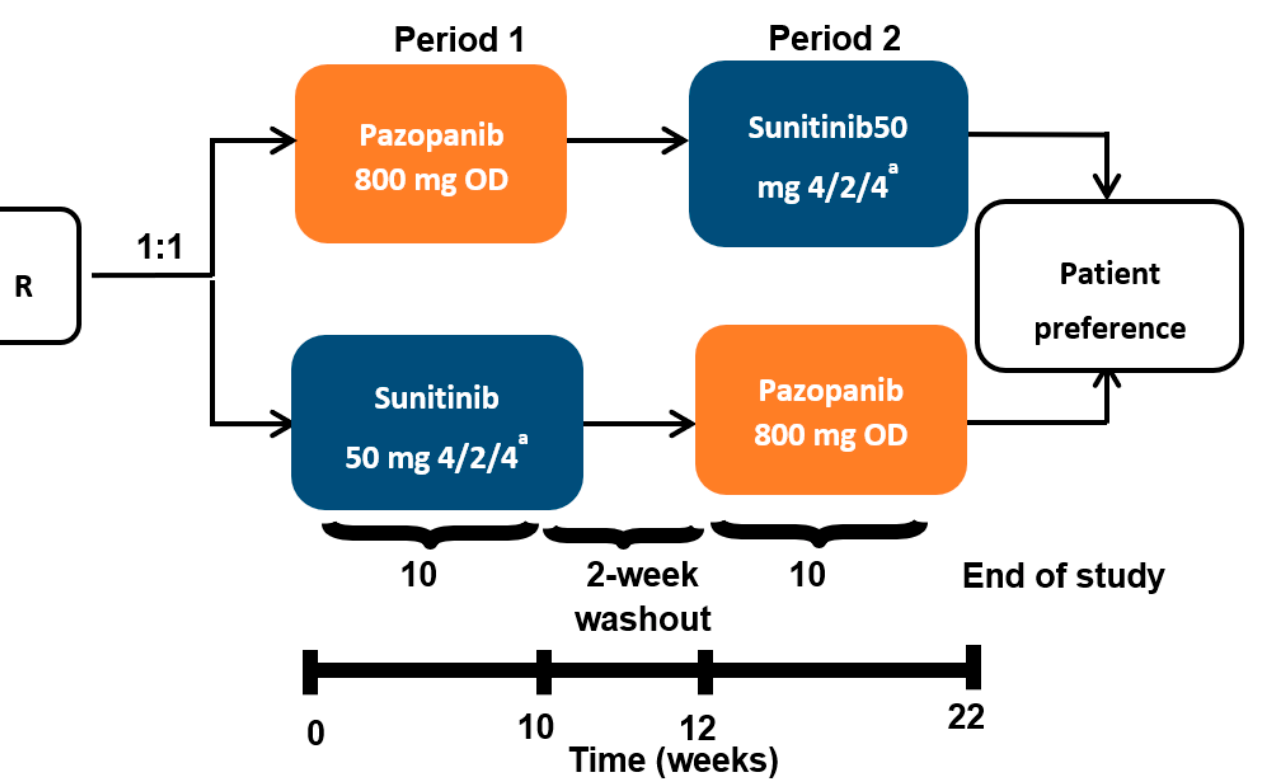
Figure 1. PISCES protocol and blood collection. m RCC patients were randomly assigned to pazopanib 800 mg per day for 10 weeks, followed by a 2-week washout, then sunitinib 50 mg per day (4 weeks on, 2 weeks off, 4 weeks on) for 10 weeks, or the reverse sequence. Blood samples from patients were collected prospectively at baseline (T1), 10 weeks (T2) and 20 weeks (T3) after the start of anti-angiogenic therapy. R stands for randomization. OD stands for oral administration once daily. a 4 weeks on treatment → 2 weeks of matching placebo → 4 weeks on treatment.